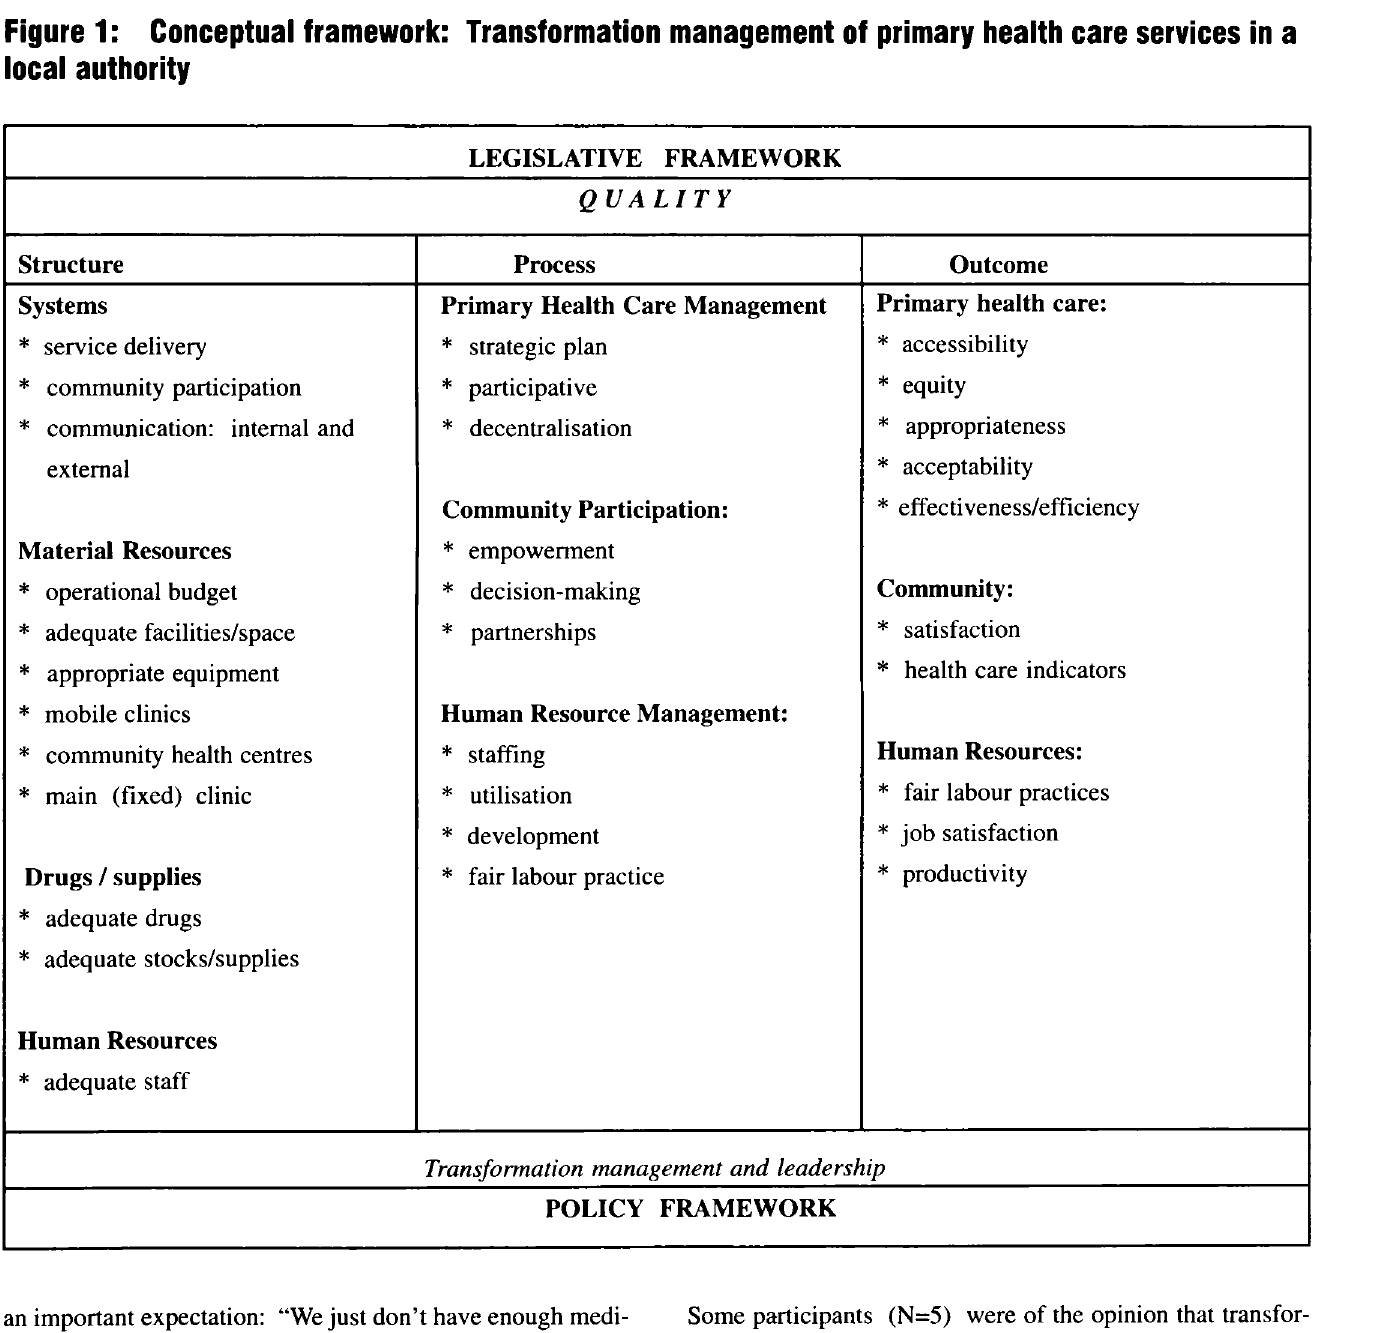
Figure 1 : Conceptual framework: Transformation management of primary health care services in a local